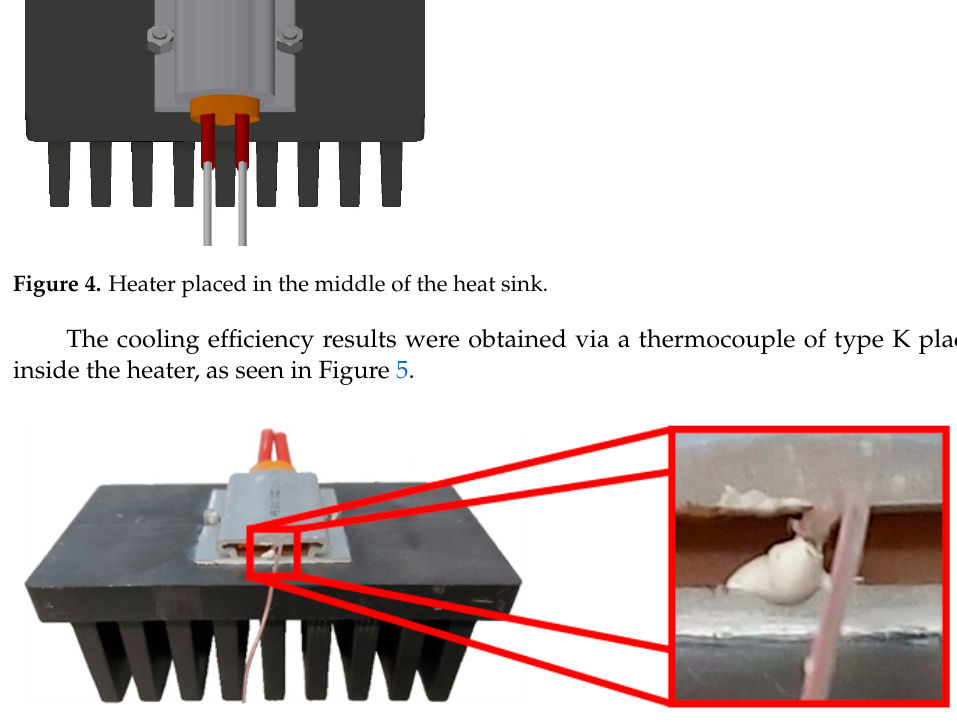
Figure 5. Placement of thermocouple on the heater. Each heat sink was measured in two positions: “default” and “upside-down”, as is shown in Figure 6. Therefore, the entry of the melt flow would change its position in regard to gravity in the case of the heat sink being produced with the melt entrance along the longer base’s side. In the case of the heat sink being produced with the melt entrance along the shorter base’s side, the entrance only moved from left to right.